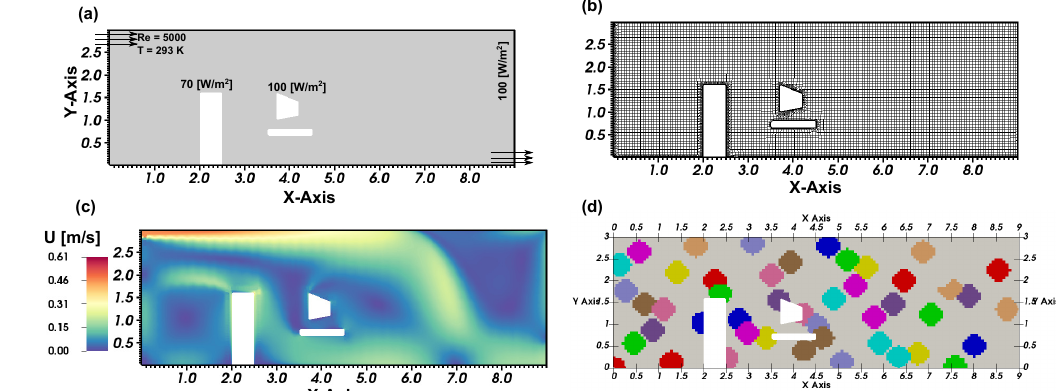
Figure 5. ( a ) The 2D computational domain with the boundary conditions is used for calculating the flow field in the domain. ( b ) The CFD computational mesh is used for computing the flow field and the transfer operator. ( c ) The computed velocity magnitude inside the room. ( d ) Sampled 50 release locations with radius 0.25 m, used in the likelihood calculation during Bayesian inference.